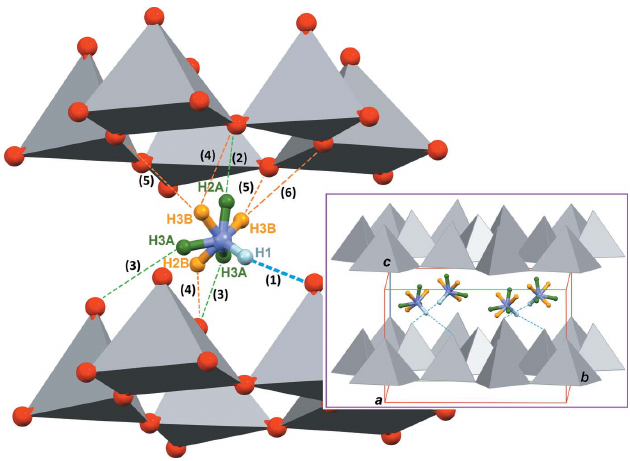
Figure 3 Part of the crystal structure of (NH 4 ) 2 V 3 O 8 showing the N—H (cid:2)(cid:2)(cid:2) O hydrogen bonds. The NH 4+ cation is disordered over two positions, N1/ H1/H2 A /H3 A (green) and N1/H1/H2 B /H3 B (orange). Hydrogen bonds are represented as dashed lines, with a label referring to entries in Table 2. The inset shows how the cations interact with the vanadium oxide matrix. Only the strongest N1—H1 (cid:2)(cid:2)(cid:2) O1 hydrogen bond is represented.